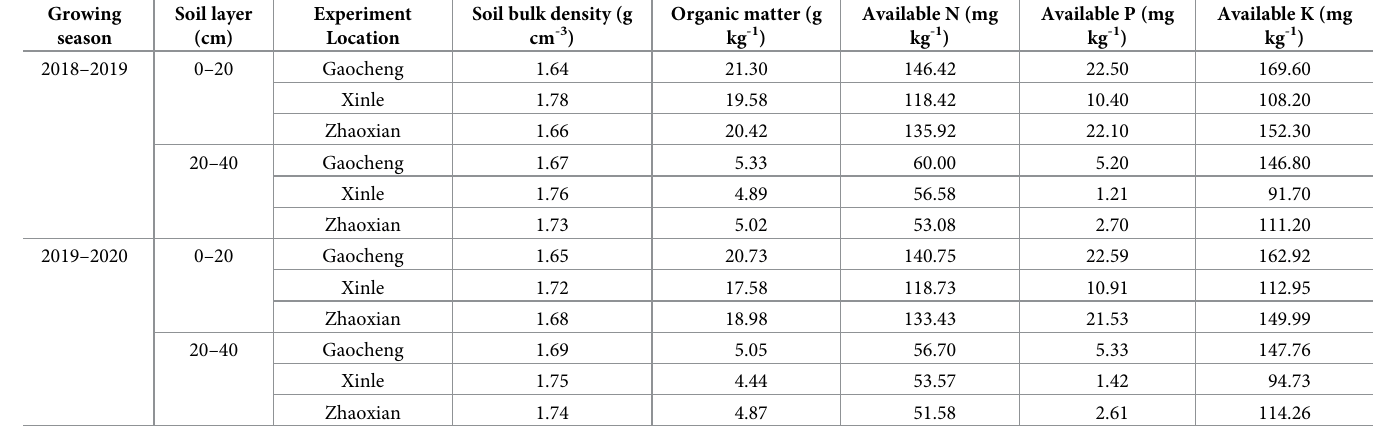
Table 1. The status of top soil before seeding in 2018 and